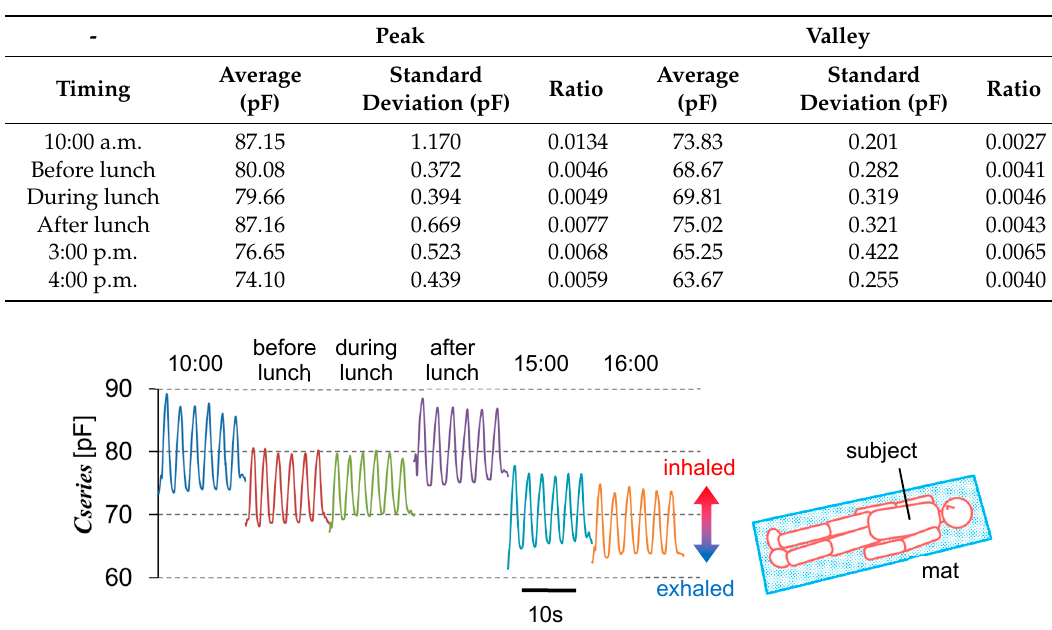
Table 2. List of statistical evaluations of the peak and valley values in Figure 3.